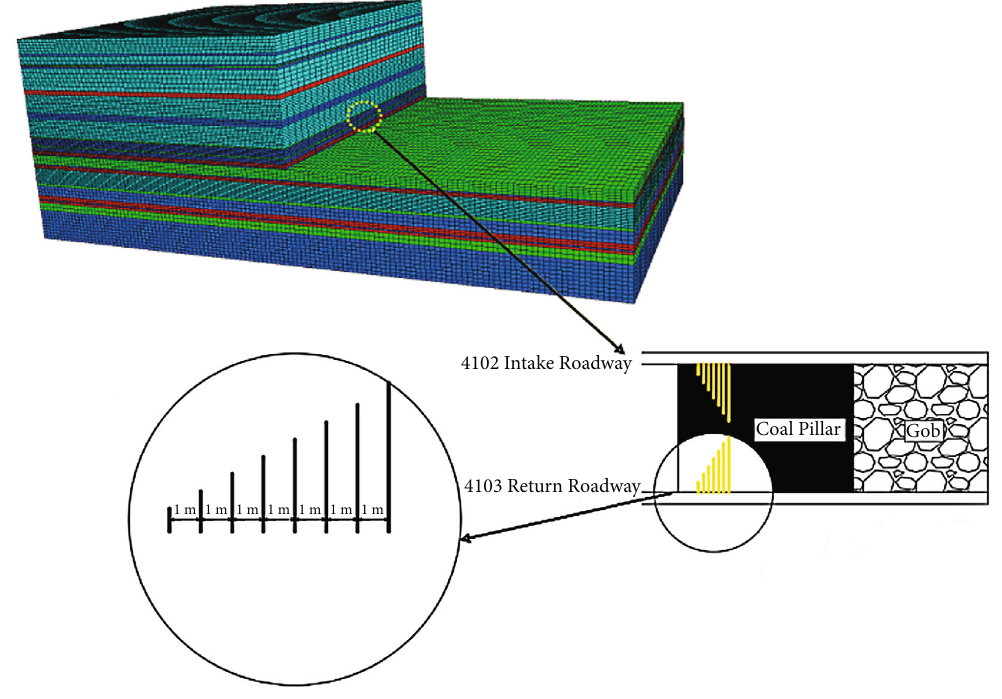
Figure 6: Borehole stress gauge monitoring station.